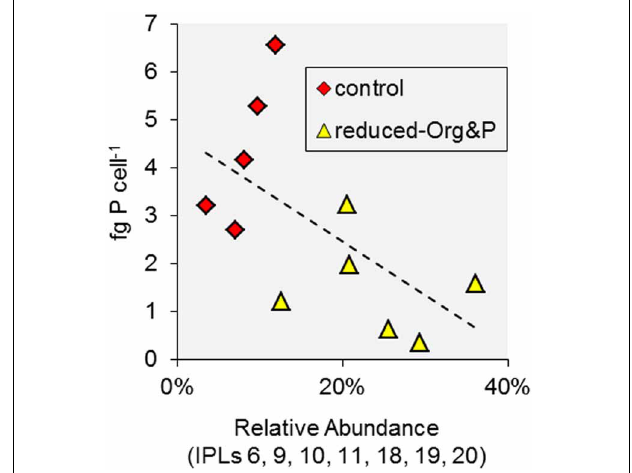
FIGURE 9 | Factors associated with IPL variability in T. kodakarensis. The relative abundance of IPLs associated with cells cultured in reduced-Org&P media were inversely correlated with cell P quota ( p = 0 .